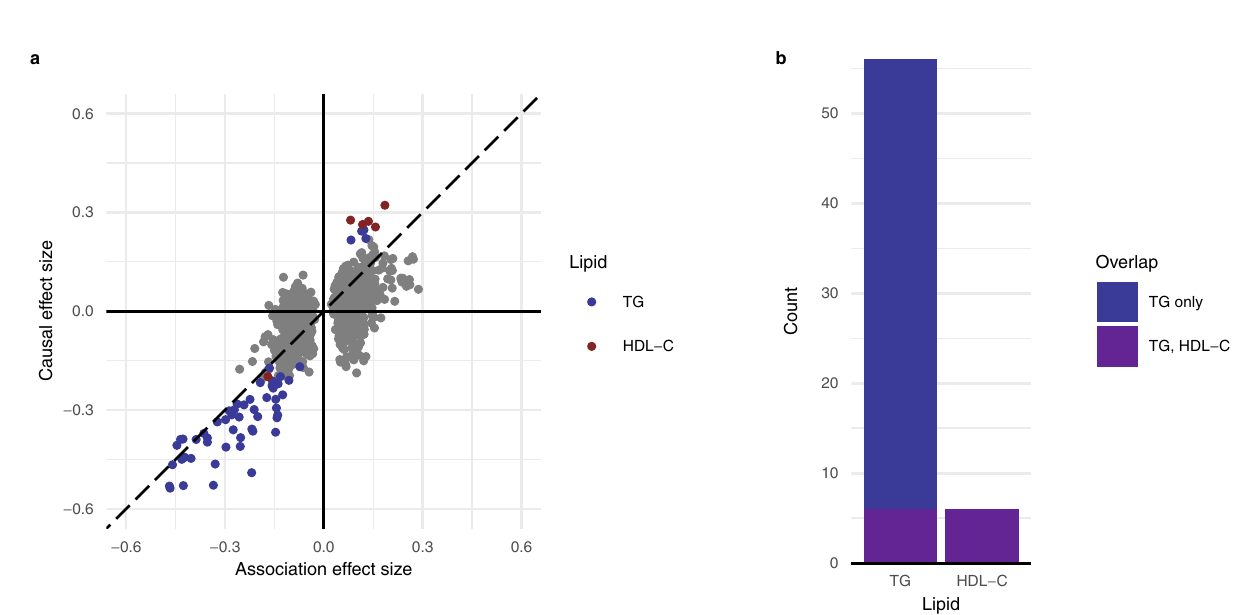
Fig.2|Mendelianrandomizationrevealsgenesaffectedbylipids.a Comparison between association (transcriptome-wide analysis) linear regression and causal (MR) Wald ratio effect sizes for TG, HDL-C, and LDL-C. The point depicted in color